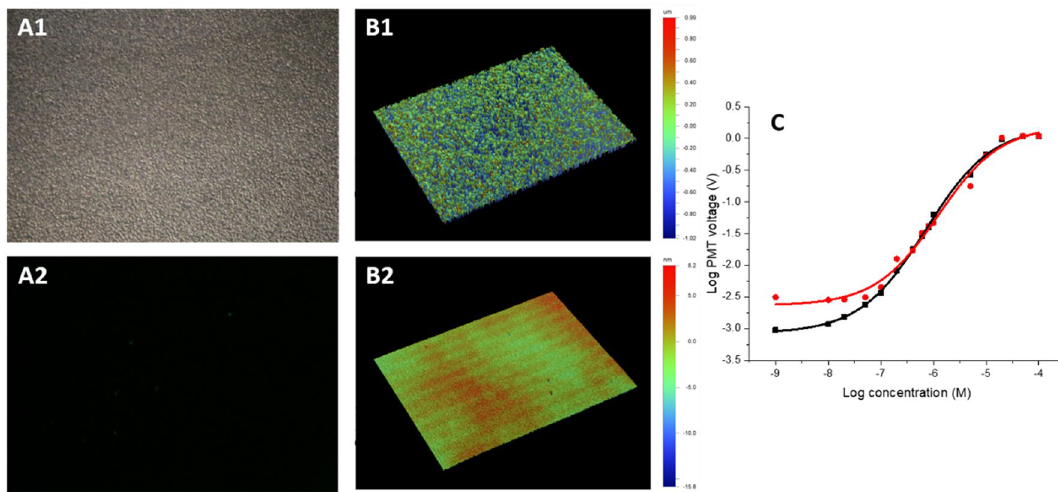
Figure 4. ( A ) Image of the conventional Si surface after etching using dark field microscopy with a 20 × objective lens. ( B ) Interference image of SOI (top) and standard Si (bottom) wafer chips using VSI mode. The images were processed using the auto-scale mode, with the SOI having a total scale of = 24 nm, while the conventional Si chip has a total scale = of 2.01 µm—thus = 84 × greater. ( C ) PMT voltage as a function of fluorescein concentration with the type of chamber material as a parameter using logarithmic scales for both axes; red is conventional Si substrate and black is SOI-based